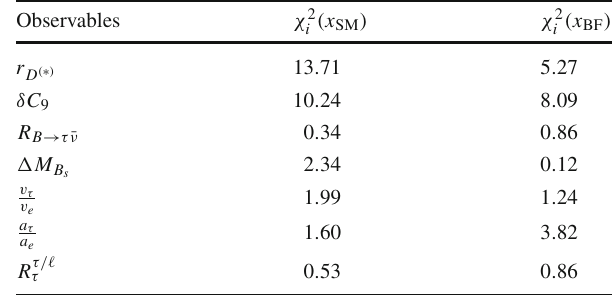
Table 1 The best-fit points along with the flavour suppression factors for each of the relevant RPV couplings are reported RPV couplings